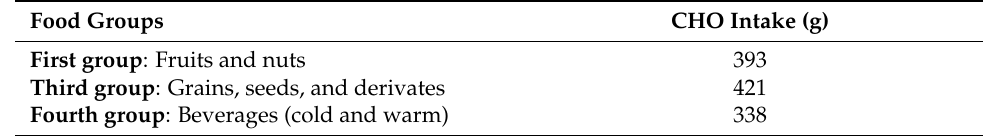
Table 4. Carbohydrate intake by food groups.